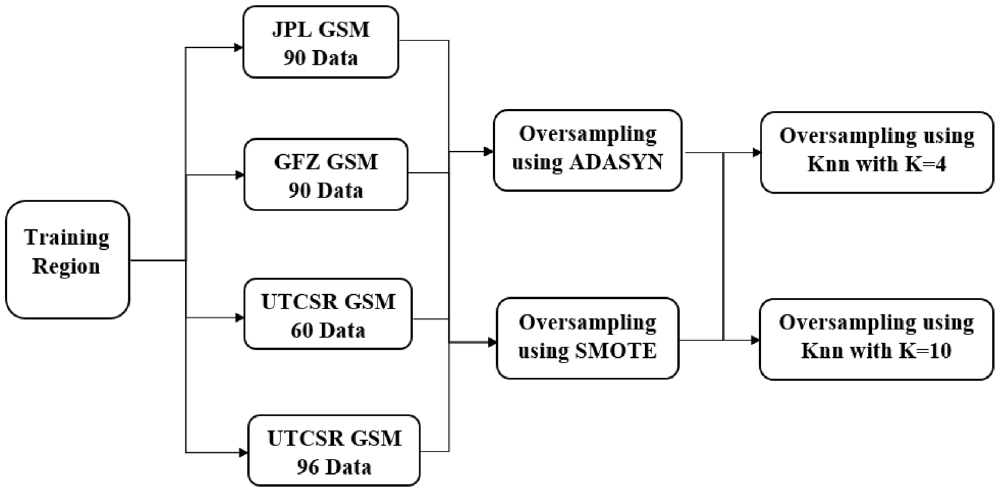
Figure 5. The process of building our training